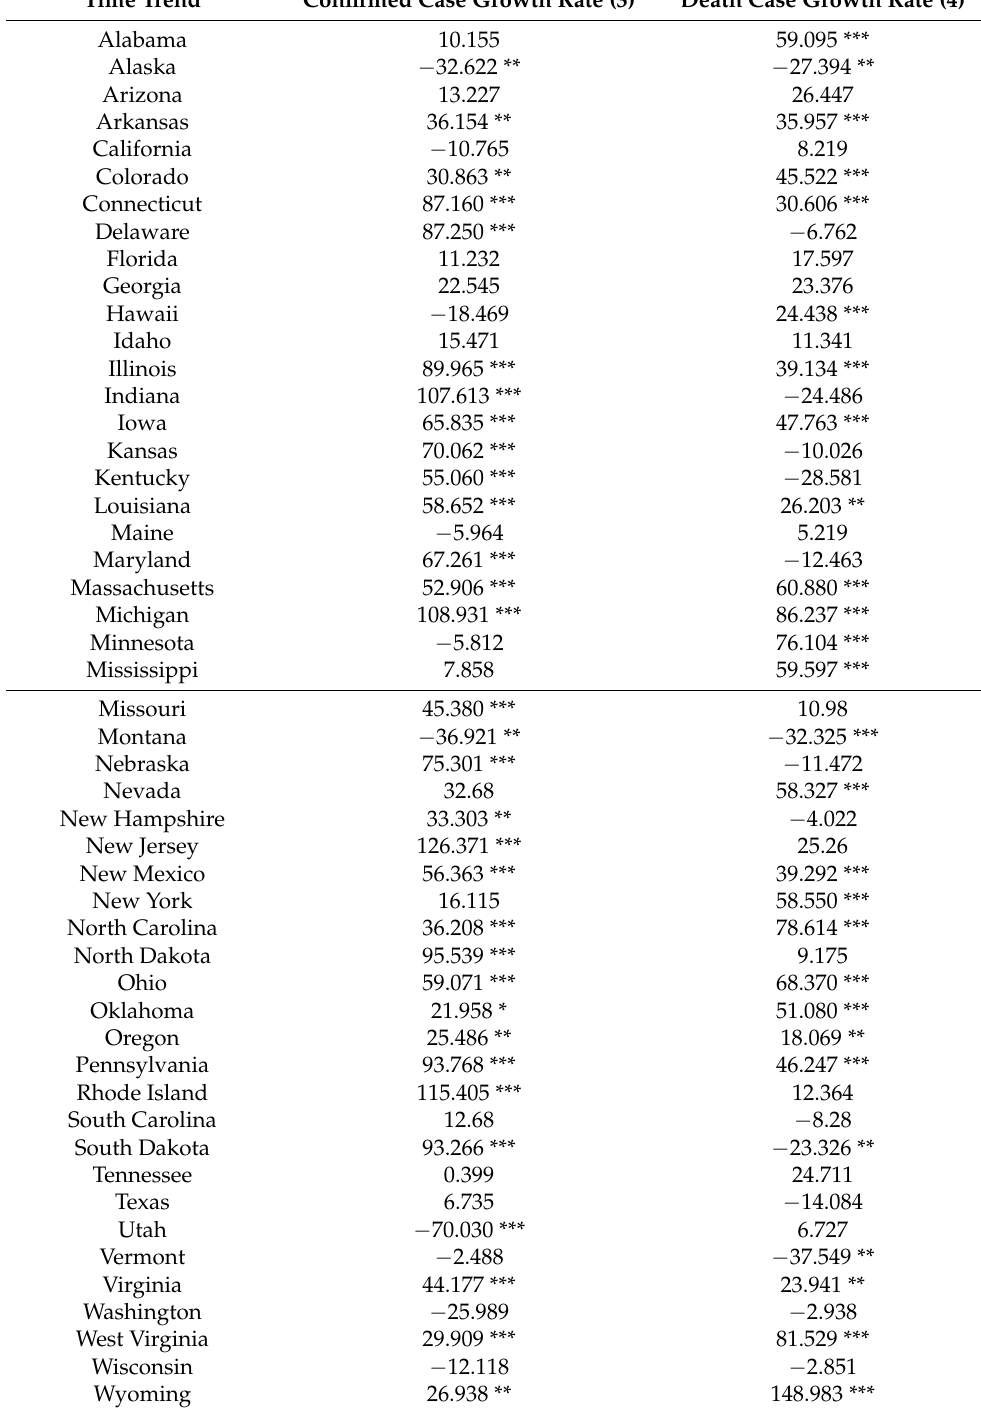
Table A3. State-specific time trends (as part of Table